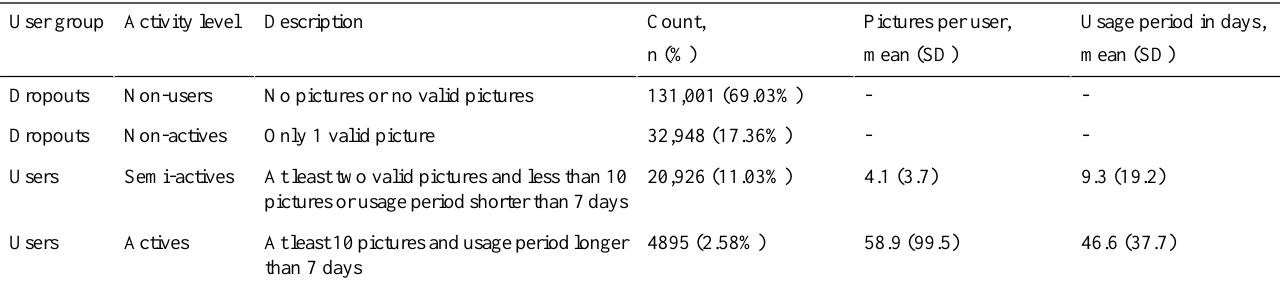
Table 3. Adherence data for users who downloaded the free dietary self-monitoring app between October 15, 2011 and April 3, 2012 (n=189,770).